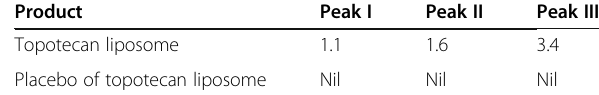
Table 4 Concurrent and prominent SAXS peaks (2 theta) Product Peak I Peak II Peak III Topotecan liposome 1.1 1.6 3.4 Placebo of topotecan liposome Nil Nil